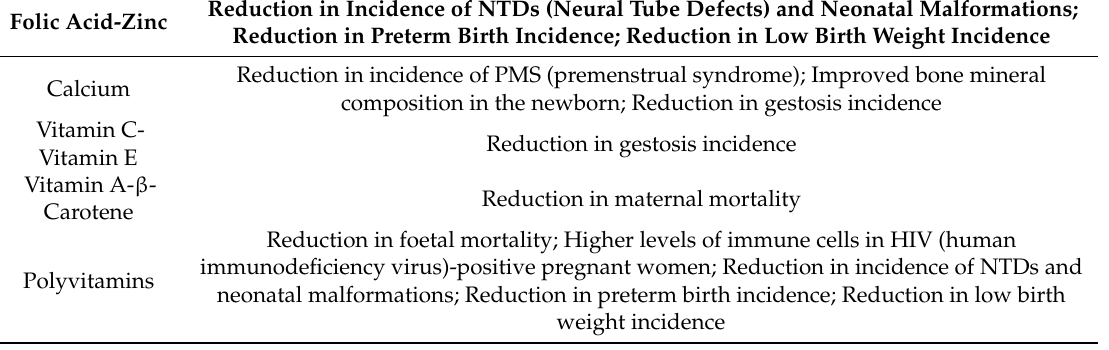
Table 1. Beneficial effects of micronutrients intake during